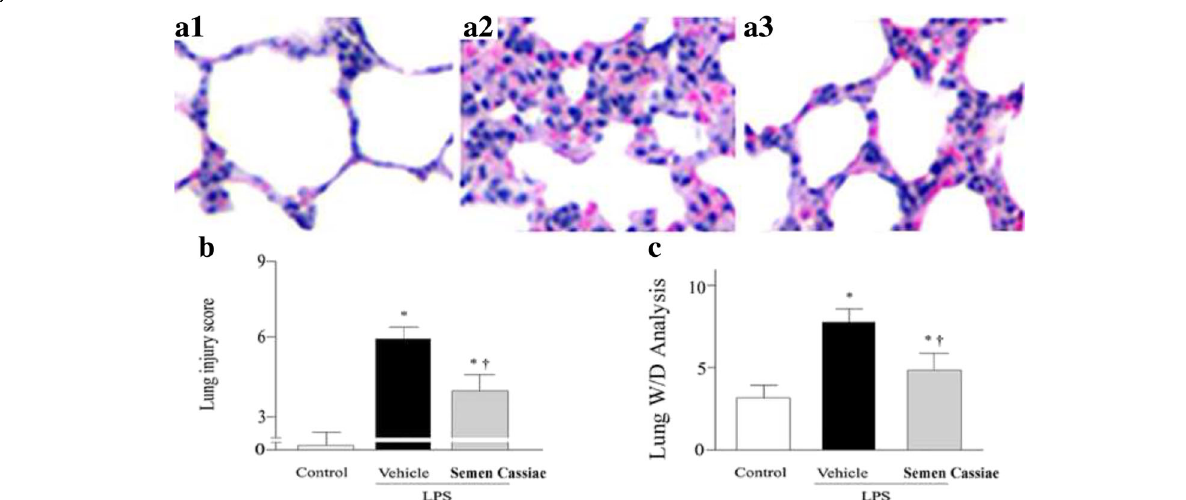
Fig. 1 Morphologic alterations of the lung were determined by photomicrography. a1) Photomicrograph of a pulmonary section from a rat of control group. a2) Photomicrograph of a pulmonary section from a rat of lipopolysaccharide (LPS) + Vehicle group. a3) Photomicrograph of a pulmonary section from a rat of LPS + Semen Cassiae group. Magnification: ×400. Alterations of lung injury scores (b), or the ratio of the lung wet to dry weight (W/D) (c) in control or LPS challenged rats treated with vehicle or Semen Cassiae . Data are expressed as the mean ± SEM and compared by one-way analysis of variance and the Student-Newman-Keuls method. We performed histopathological scores by using Kruskal-Wallis one-way analysis of variance on ranks and the Student-Newman-Keuls method. * P < 0.05 when compared with control group; † P < 0.05 when compared with LPS + Vehicle group